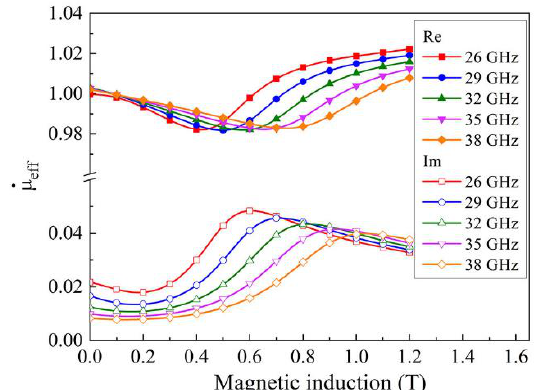
Figure 9. The dependence of the effective magnetic permeability on the magnetic field, calculated for several frequencies for a composite with 3.8% flakes and 2% CNT.